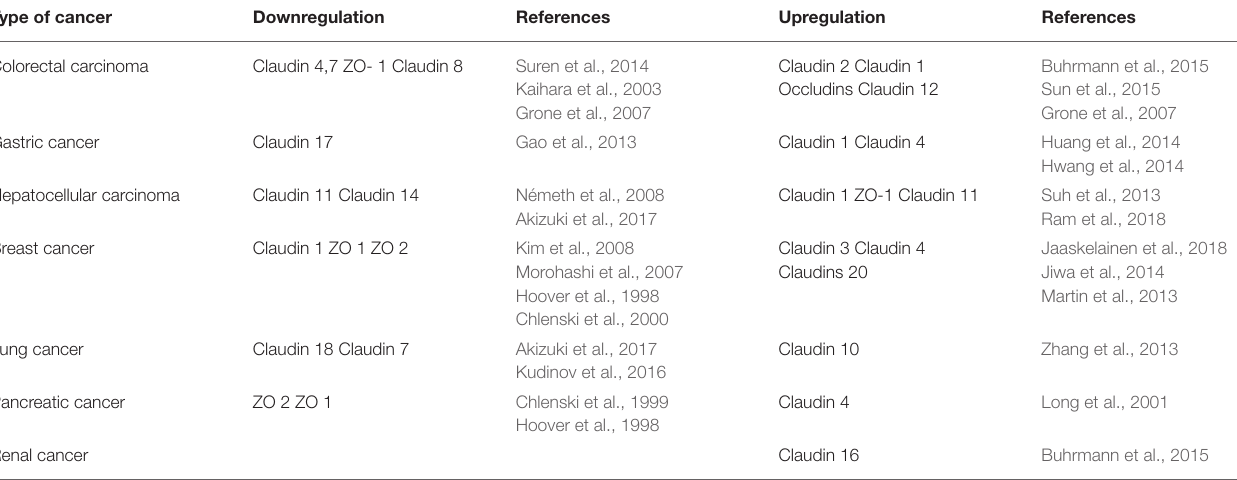
TABLE 1 | Summarizes the role of various TJ in